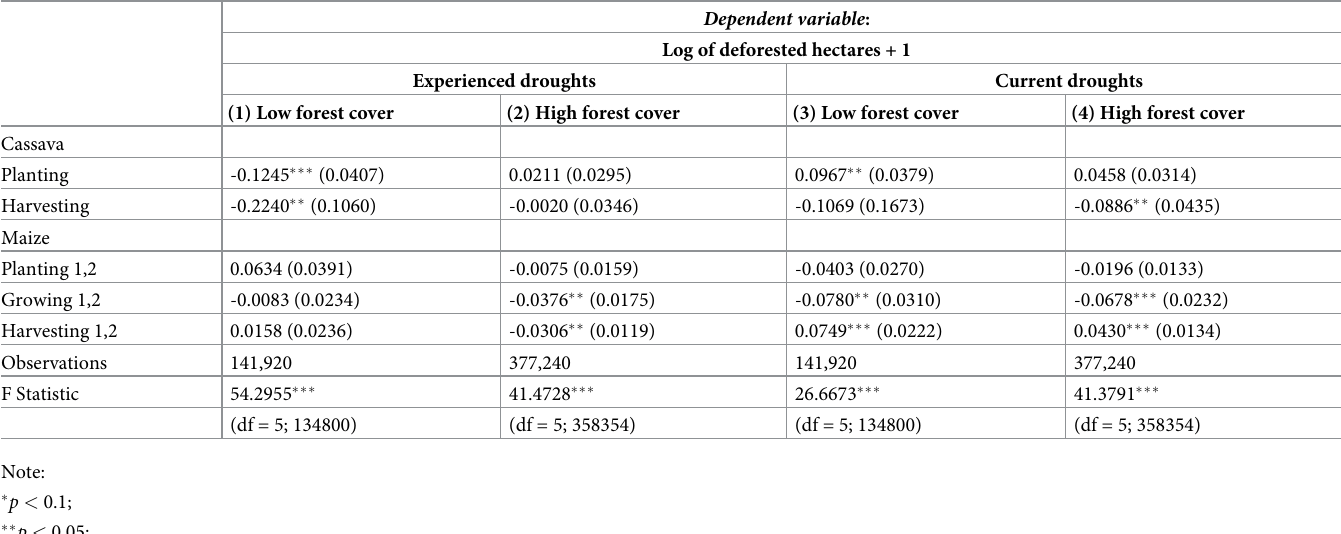
Table 3. Deforestation and droughts over the main agricultural periods and cycles, differentiating between low ( � 75%) and high ( > 75%) forest cover in year 2000. Dependent variable : Log of deforested hectares + 1 Experienced droughts Current